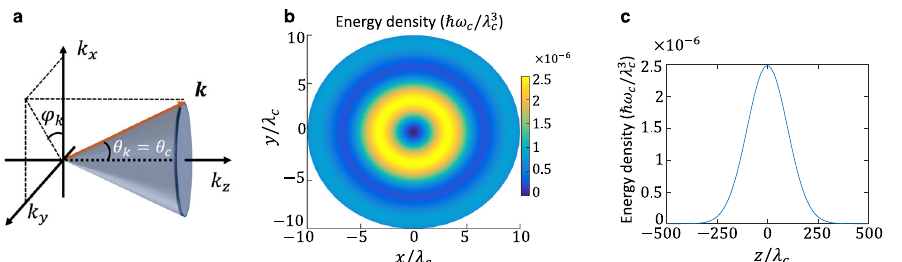
Fig. 2 Pro fi le of a Bessel pulse in wave-vector space and real space. a Schematic of the spectral distribution of a Bessel pulse. b The energy density (in unit of _ ω c = λ 3 c ) distribution of a Bessel pulse in the xy -plane. c The envelope of the Bessel pulse in the propagating direction is of a Gaussian type. Here, ω c is the center frequency of the pulse with center wavelength λ c . The polar angle of the Bessel pulse is taken as θ c = 0.2 π . The other parameters are taken as m = 2 and C = 0